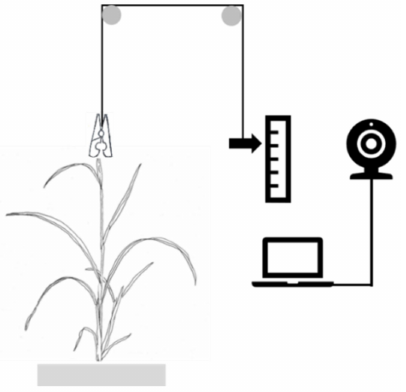
Figure 4. Schematic setup for leaf elongation rate